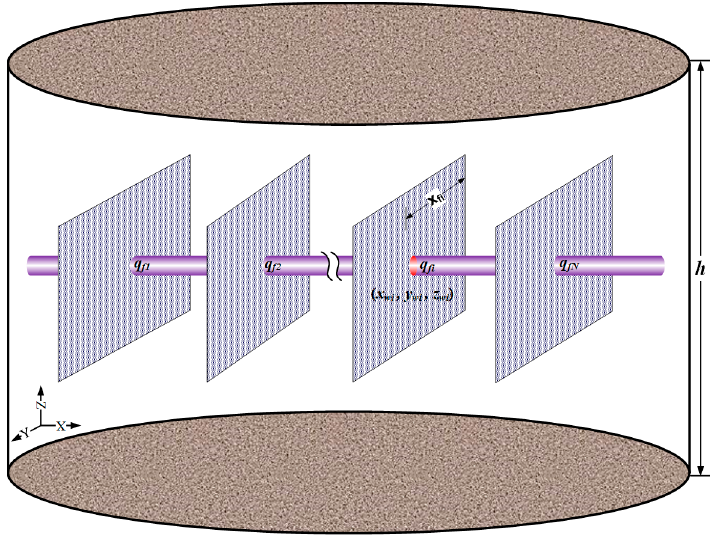
Figure 2. The Physical model of an MFHW in the circular-bounded formation.